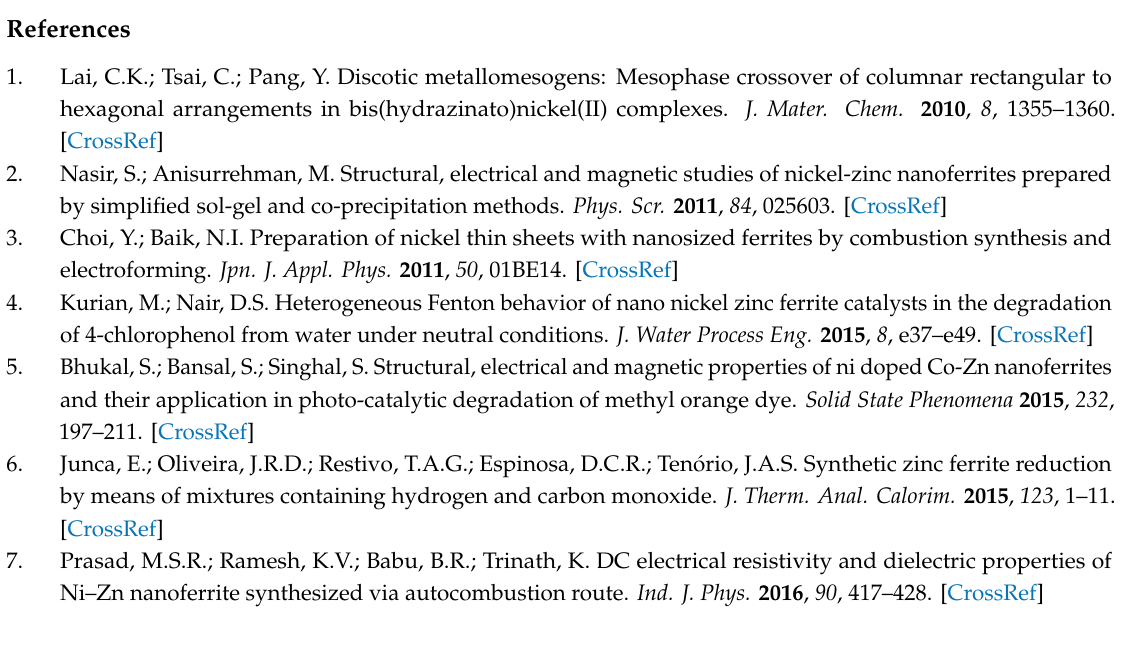
Figure 7. The variation of dielectric loss tangent tan(δ) as a function of lnf(Hz) of Ni 1-x Zn x Fe 2 O 4